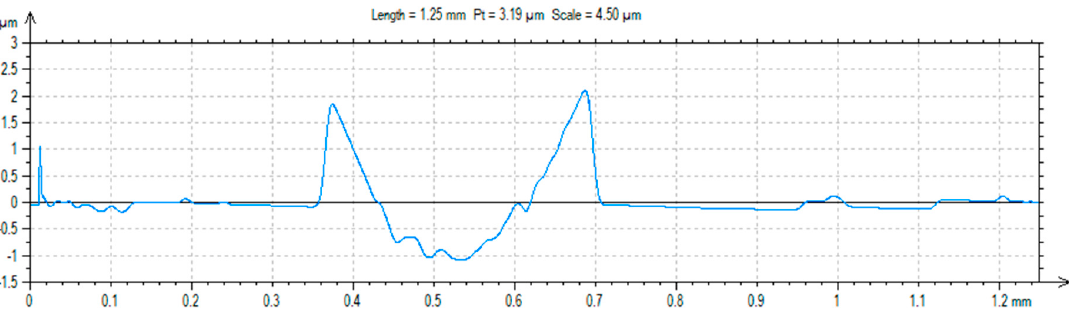
Figure 15. Trace after ball-on-plate test for material (Cu) after Ti alloying.